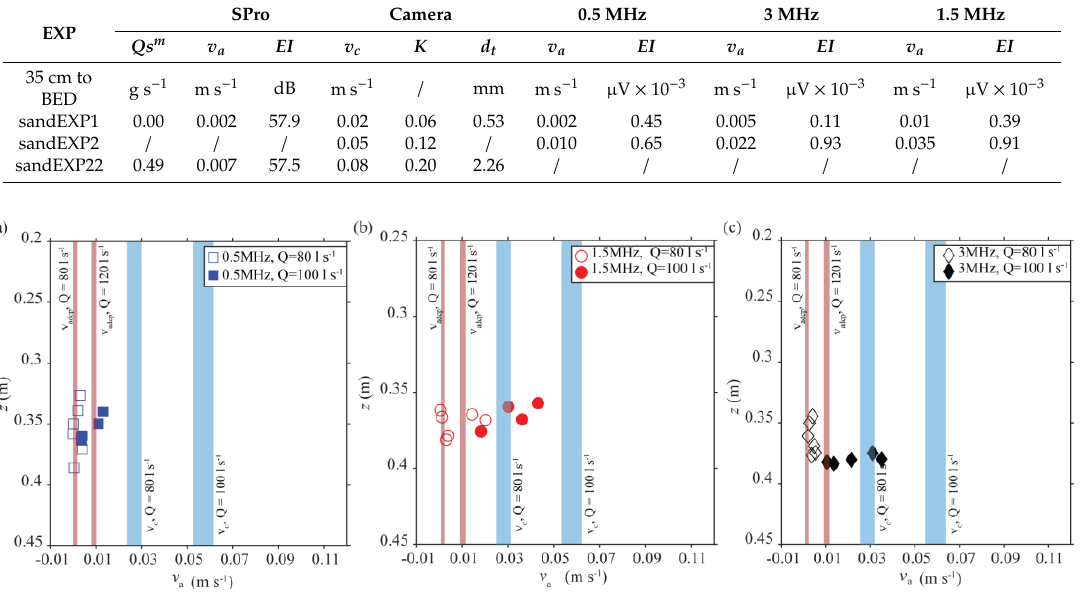
Figure 7. Bedload velocities measured by the tilted UVPs for both conditions, Q = 80 l s − 1 and Q = 100 l s − 1 : ( a ) 0.5 MHz; ( b ) 1.5 MHz; ( c ) 3